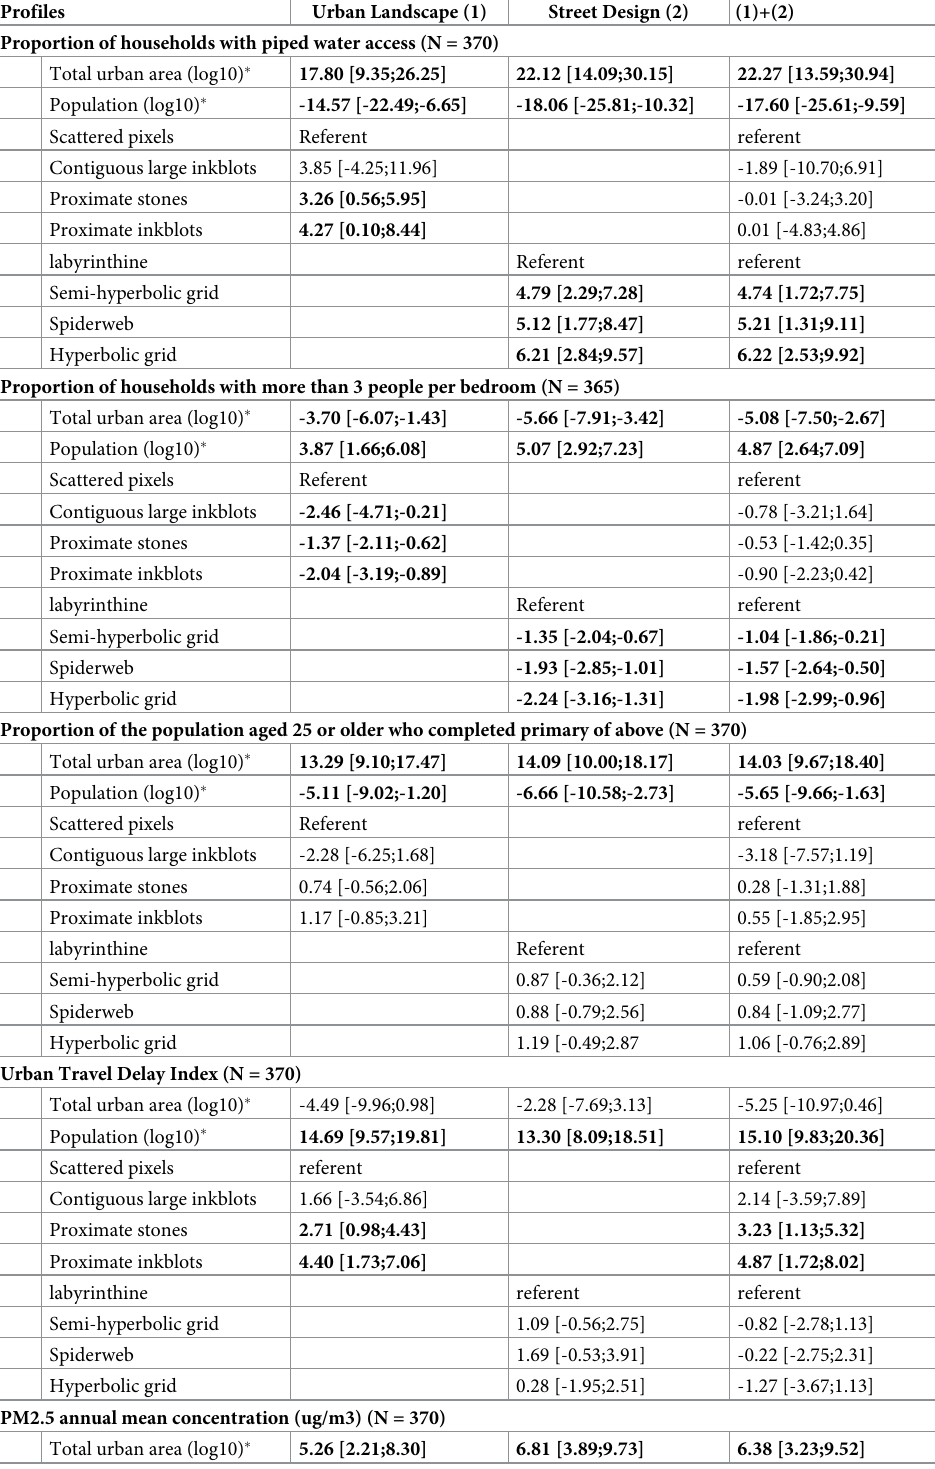
Table 6. Multilevel modeling of the associations between social determinants of health and air pollution indica- tors with urban landscape and street design